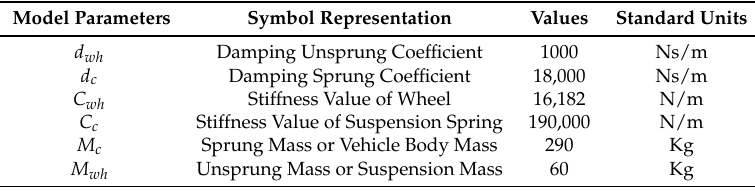
Table 1. List of parameters of quarter-car model.